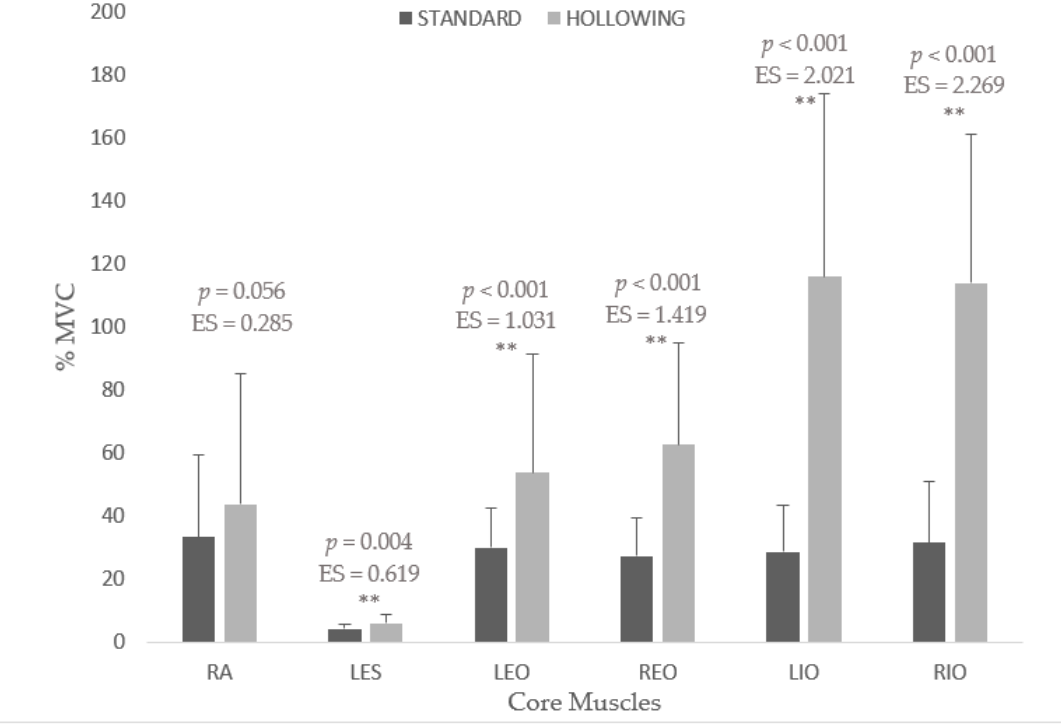
Figure 3. Comparison of normalized electromyographic activity (%MVC) of the core muscles across experimental conditions. Abbreviations: RA, rectus abdominis; LES, lumbar portion of erector spinae; LEO, left external oblique; REO, right external oblique; LIO, left internal oblique; RIO, right external oblique; STANDARD, prone plank standard condition; HOLLOWING, prone plank hollowing condition; ES, Effect Size. ** Significant differences on EMG muscular response between both prone plank conditions.